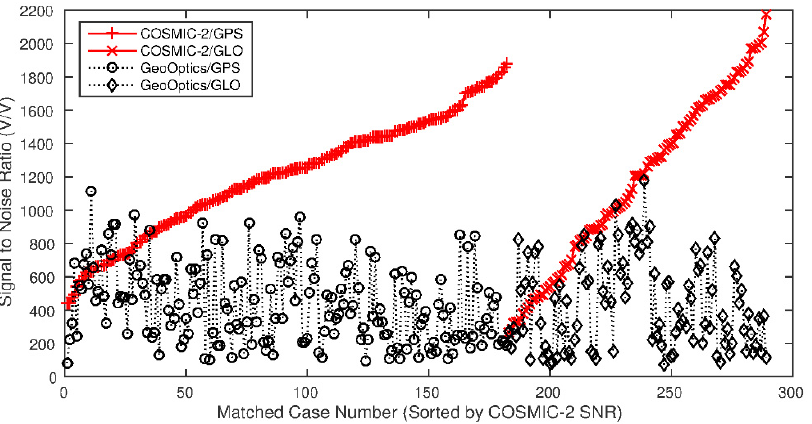
Figure 10. SNR comparison for the SRO pairs between COSMIC-2/GPS (red solid plus line) and GeoOptics/GPS (black-dotted circle line) as well as between COSMIC-2/GLONASS (red solid cross line) and GeoOptics/GLONASS (black-dotted diamond line).